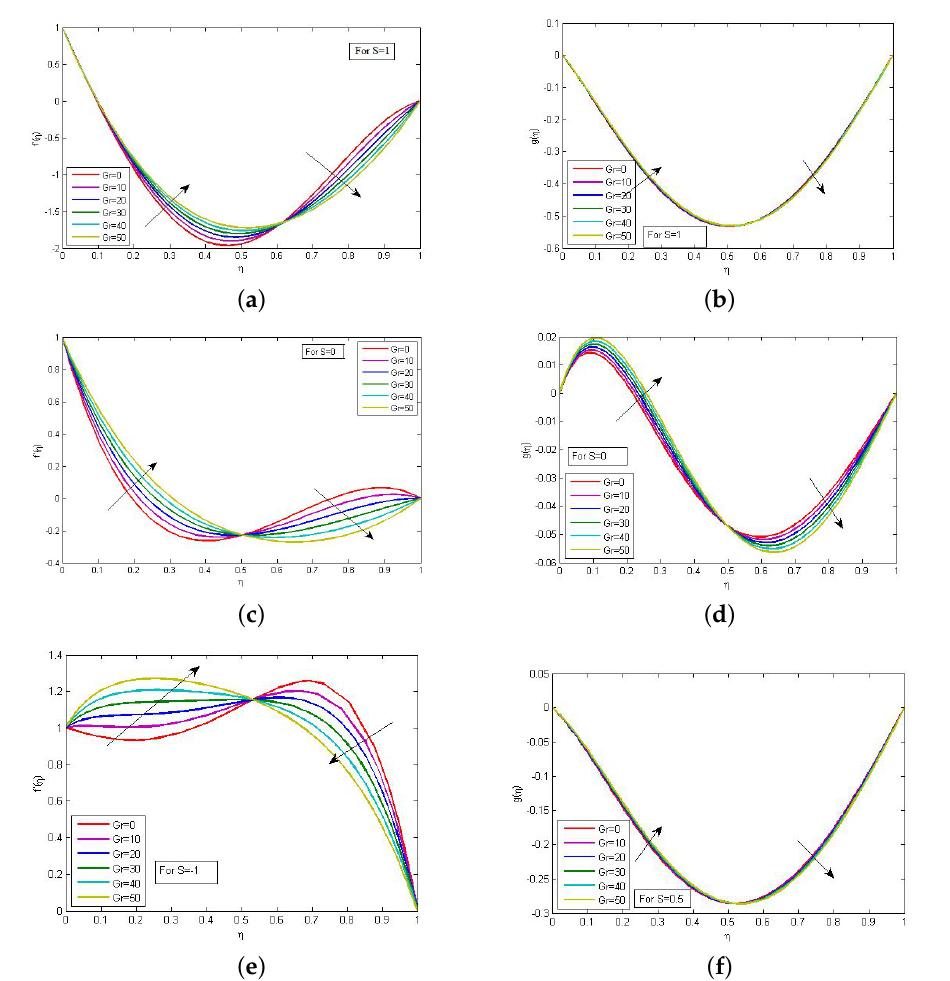
Figure 2. Influence of Gr on f (cid:48) ( η ) for cases ( a ) S = 1.0 ( c ) S = 0.0 ( e ) S = − 1.0, and influence of Gr on g ( η ) for cases ( b ) S = 1.0 ( d ) S = 0.0 ( f ) S = − 1.0.